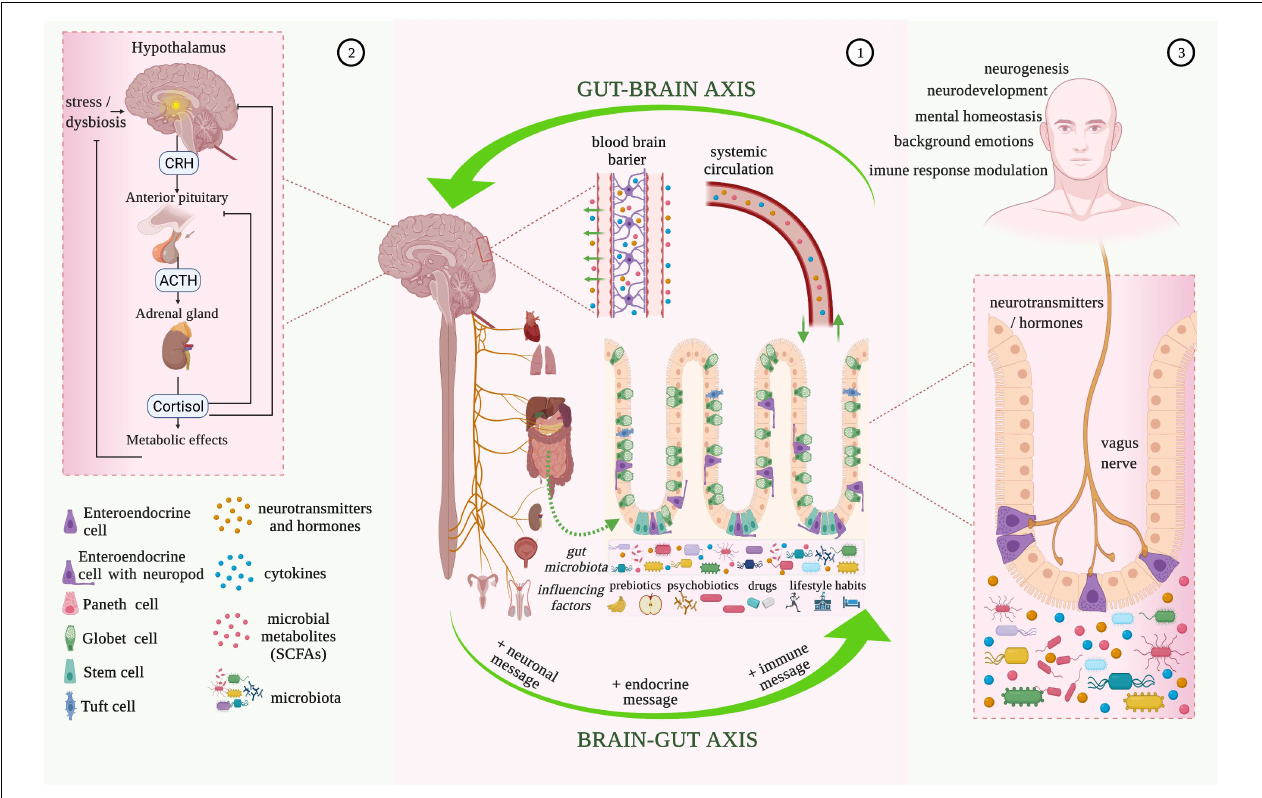
FIGURE 1 | Microbiota-gut-brain bidirectional relationship. 1. The vagus nerve transfers information on the state of the digestive system to the brain through sensory fibers. It sends neuronal, endocrine, and immune messages to the gut microbiota influencing the state of brain health through various pathways (e.g., by bidirectional vagus nerve-to-brain communication, or through the enteric nervous system (ENS) and enteroendocrine cells with neuropods). Gastrointestinal bioactive molecules (neurotransmitters and hormones, cytokines, and microbial metabolites) also produced under the influence of external factors, such as prebiotics, psychobiotics, drugs, and lifestyle habits, end up in the brain tissue through the blood-brain barrier that consists of endothelial cells of the brain capillary wall, astrocyte end-feet surrounding the capillary, and pericytes embedded in the capillary basement membrane. 2. Hypothalamic-pituitary-adrenal (HPA) axis activation is characterized by the release of corticotropin-releasing hormone (CRH) from the hypothalamus, which then stimulates the delivery of adrenocorticotropic hormone (ACTH) from the anterior pituitary gland. ACTH acts on the adrenal gland to produce and release the stress hormone (cortisol), which is responsible for the modulation of the intestinal epithelial barrier and immune responses. 3. Enteroendocrine cells with neuropods are one of the most important influencers of bidirectional brain-gut communication. The innervation induced to the enterochromaffin-cell signaling to neuronal circuits by the vagus nerve, modulates the pain response, background emotions, immune-response, neurogenesis, and neurodevelopment. The vagus nerve also has immunomodulatory properties and plays an essential role in gastrointestinal and psychiatric disorders (e.g., depression, posttraumatic stress disorder, anxiety) (image created using the BioRender application; https://app.biorender.com).